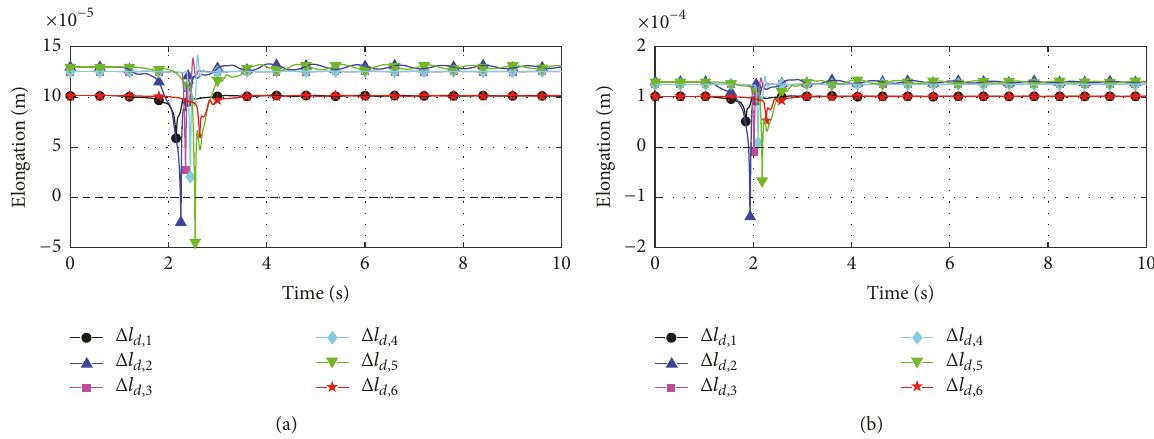
wire, the variation of the contact forces is periodic along the span when the pantograph moves at a constant speed for a long time. Second, because the droppers increase the stiffness variation and the wave reflection in the catenary, a larger variation of the contact forces occurs when the pantograph passes the droppers. Third, for the simple stitched catenary, the two droppers nearest to the registration arms easily undergo slackening when the pantograph passes them, and for the elastic stitched catenary, the second and fifth droppers slacken more easily than the others during the passage of the pantograph. Finally, it is clear that a higher speed would cause higher levels of variation of the contact forces and would make the droppers slacken more